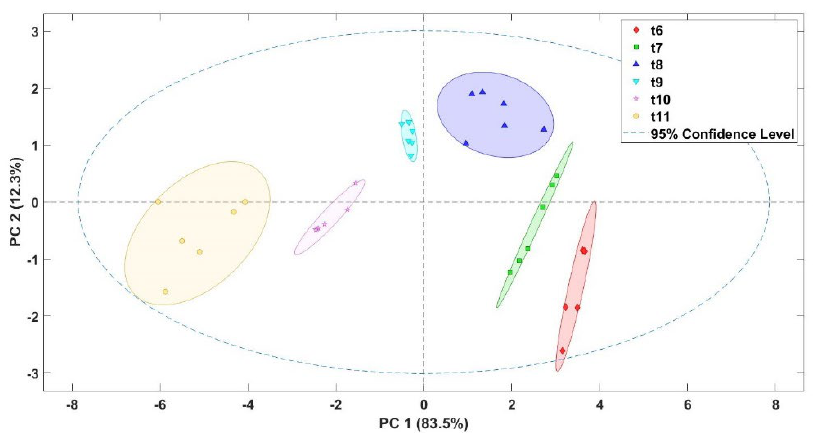
Figure 4. Score plot of the principal component analysis (PCA) for roasted coffee beans submitted to different thermal treatments (t6–t11).